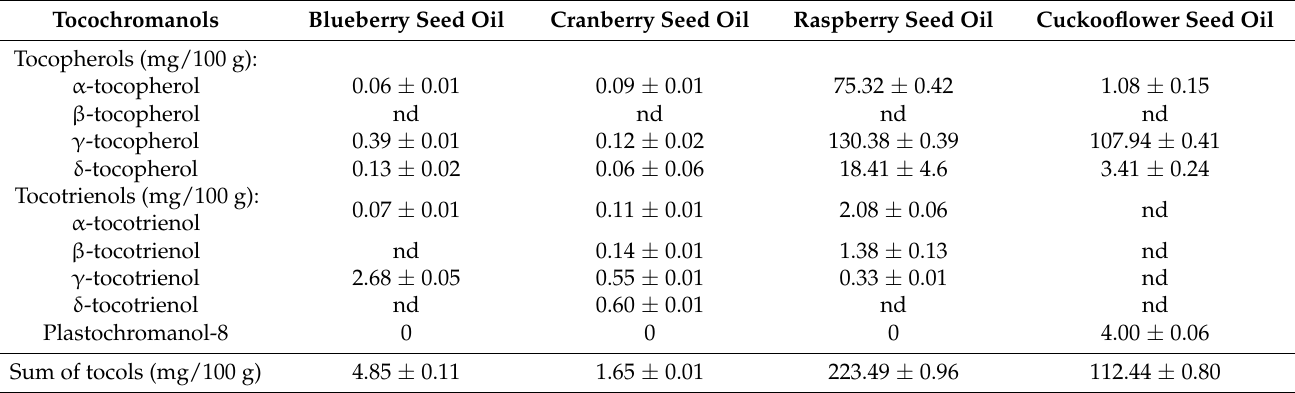
Table 4. Tocochromanols content of blueberry, cranberry, raspberry and cuckooflower seed oils obtained by sonification (mg/100